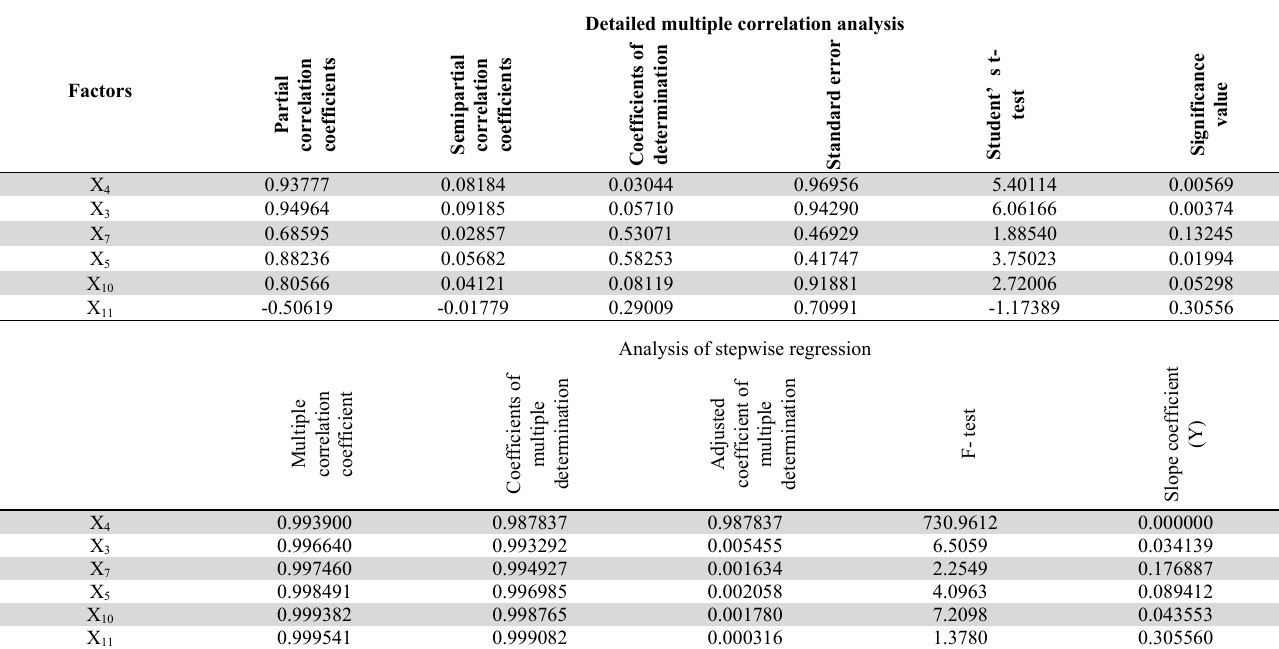
Detailed multiple correlation analysis